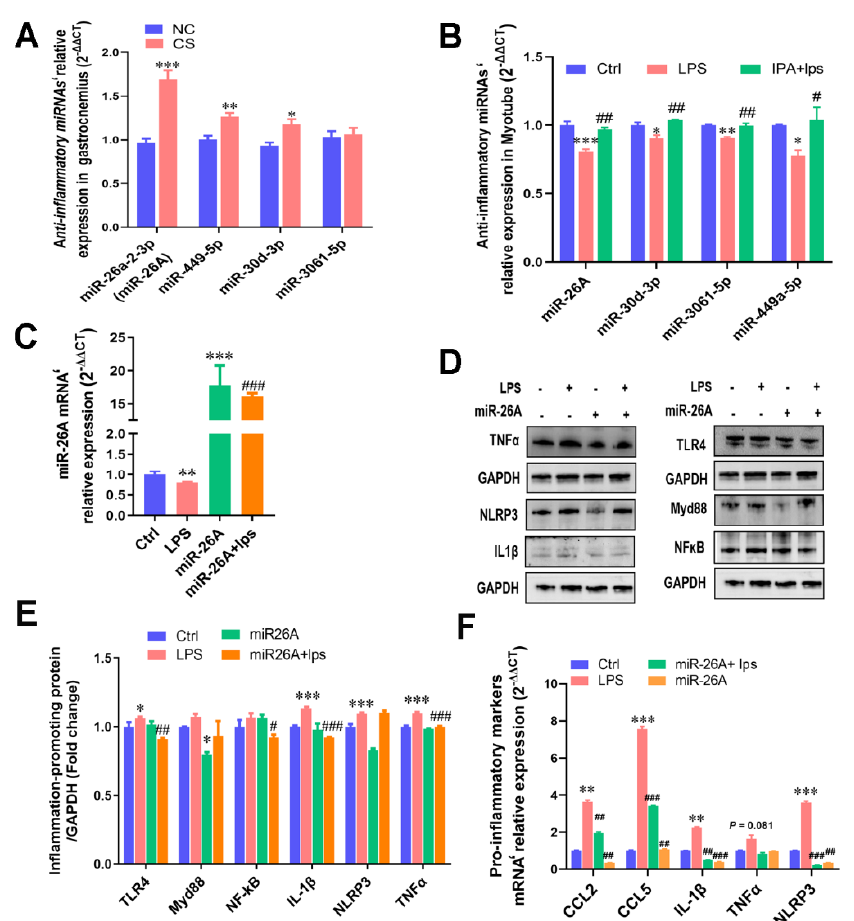
Figure 5. IPA alleviated LPS-induced cellular inflammatory response by interfering with anti-in- flammatory miRNA transcription. ( A ) qPCR validation of the anti-inflammatory miRNAs in the gastrocnemius muscle tissue with C. sporogenes colonization. ( B ) Anti-inflammatory miRNAs’ ex- pression levels of the inflammatory myotubes treated with different concentrations of IPA. ( C ) The miR-26a-2-3p (miR-26A) overexpression in myotubes. ( D – E ) The activation of miR-26A overexpres- sion on inflammatory signaling pathways TLR4/MyD88/NF- κ B and pro-inflammatory protein (NLRP3, TNF α , IL-1 β ) ( D ), as well as the protein gray value measured by ImageJ ( E ). ( F ) The sup- pression of miR-26A overexpression on pro-inflammatory markers’ mRNA expression in myotubes. The data shown are the means ± SEM, n = 3. * p < 0.05, ** p < 0.01, *** p < 0.001 vs. control cells and # p < 0.05, ## p < 0.01, and ### p < 0.001 vs. LPS treated cells. Unmarked graphs show no significant difference.